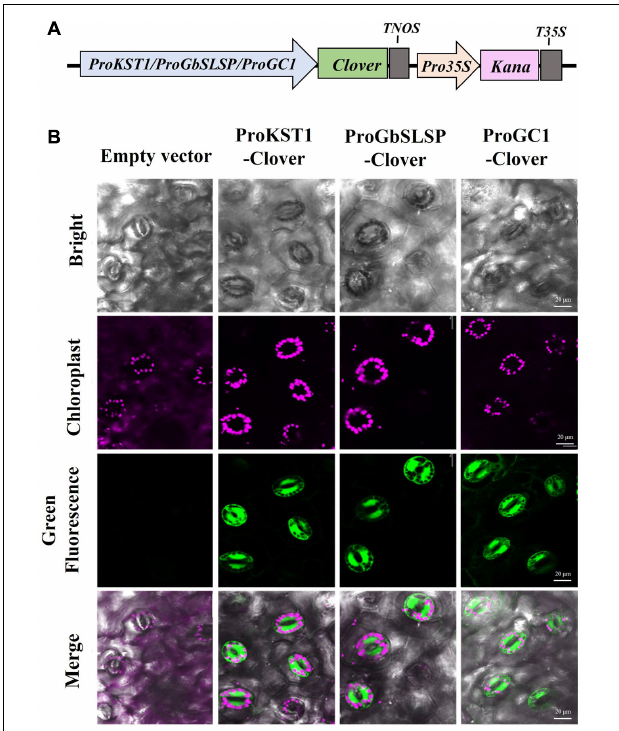
FIGURE 9 | Green fluorescent protein (GFP) expression in cotton under the control of KST1, GbSLSP, or GC1 promoter, each of which is specific to guard cells. (A) Schematic diagram of specific promoter-driven expression constructs for genetic transformation of cotton. (B) Confocal images of leaf epidermal cells of transgenic cotton plants expressing Clover under the control of the KST1, GbSLSP, or GC1 promoter. The cotton expression empty vector was observed as a negative control, with chlorophyll autofluorescence shown in magenta; scale bar, 20 µ